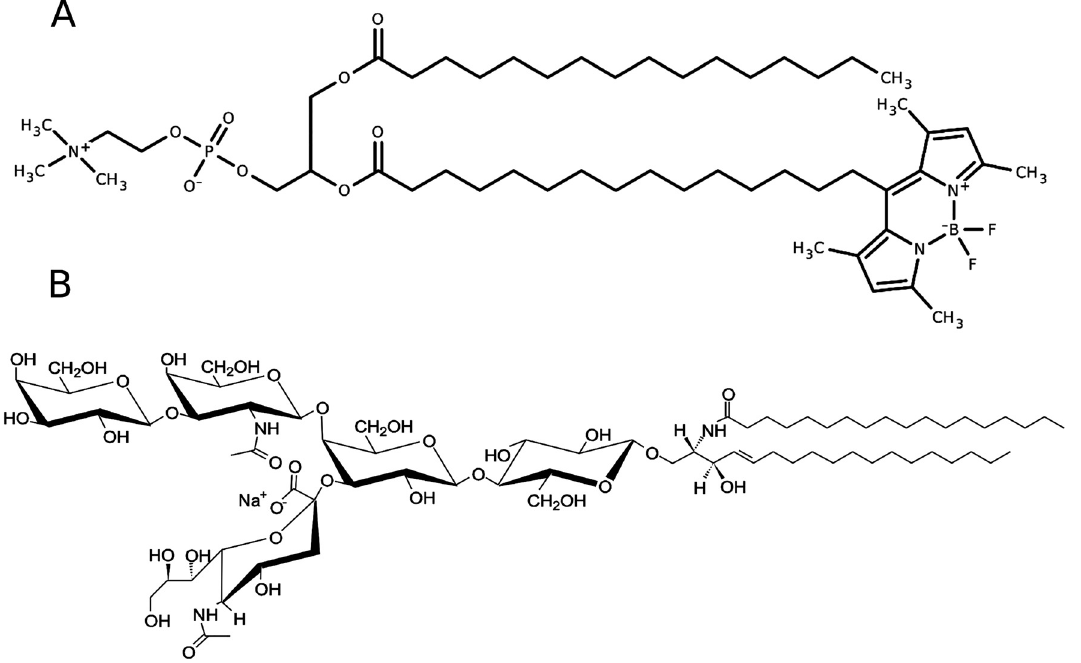
Figure 5: Molecular structures of lipid bilayer components of fluorescently labeled GM 1 -liposomes based on egg phosphatidylcholine: A – BODIPY-phosphatidylcholine {1-palmitoyl-2-[15-(4,4-di fl uoro-1,3,5,7-tetramethyl-4-bora-3 a ,4 a -diaza- s -indacene-8-yl)pentadecanoyl]- sn - glycero-3-phosphocholine}; B – shown is a representative structure of ganglioside GM 1 from bovine